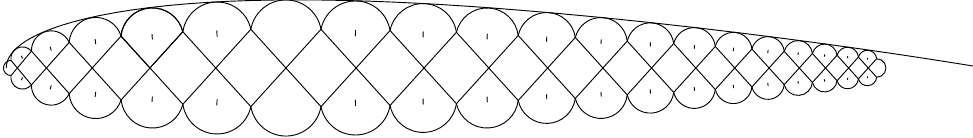
Figure 17. NACA0014 profile of a rectangular wing.